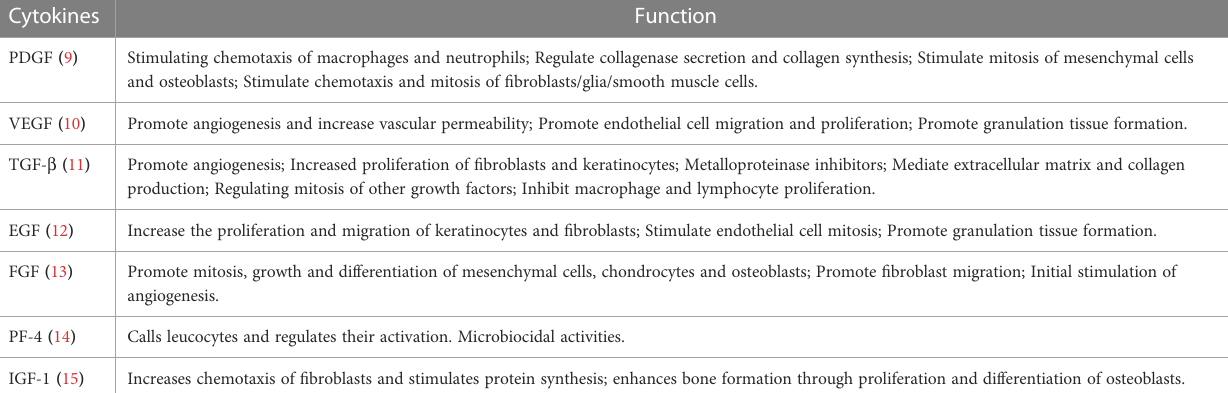
TABLE 1 Cytokines in platelet-rich